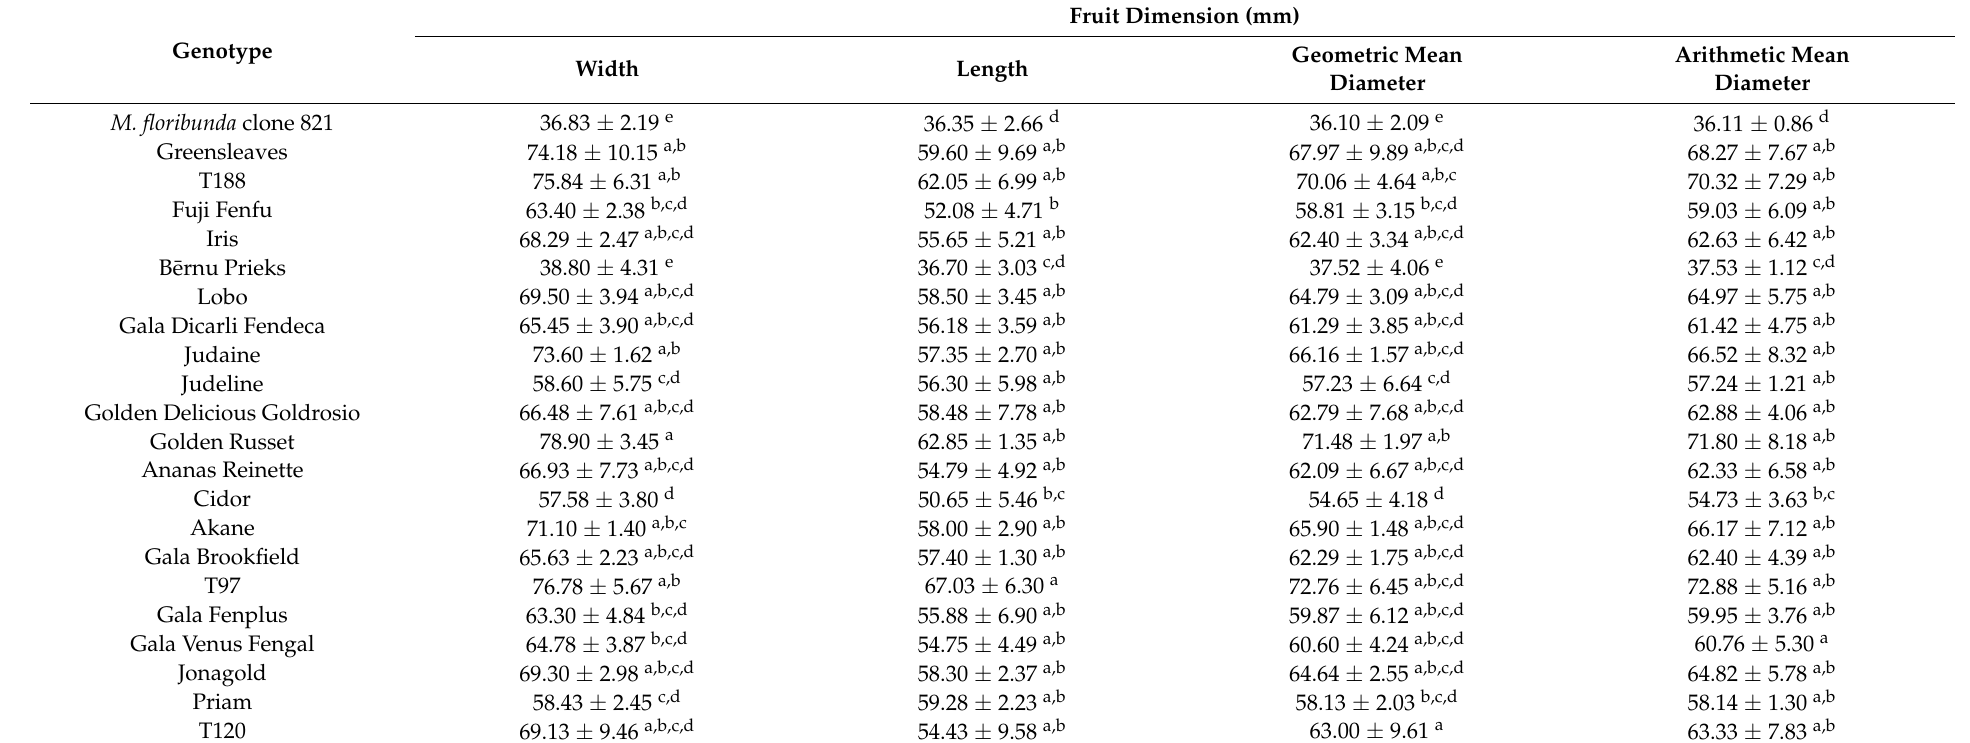
Table 3. Dimensional attributes of different apple